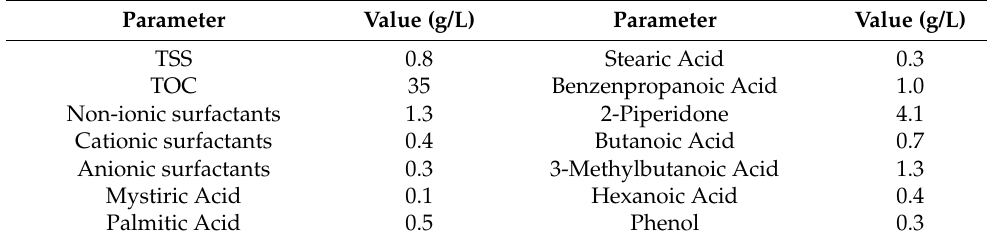
Table 1. Composition of